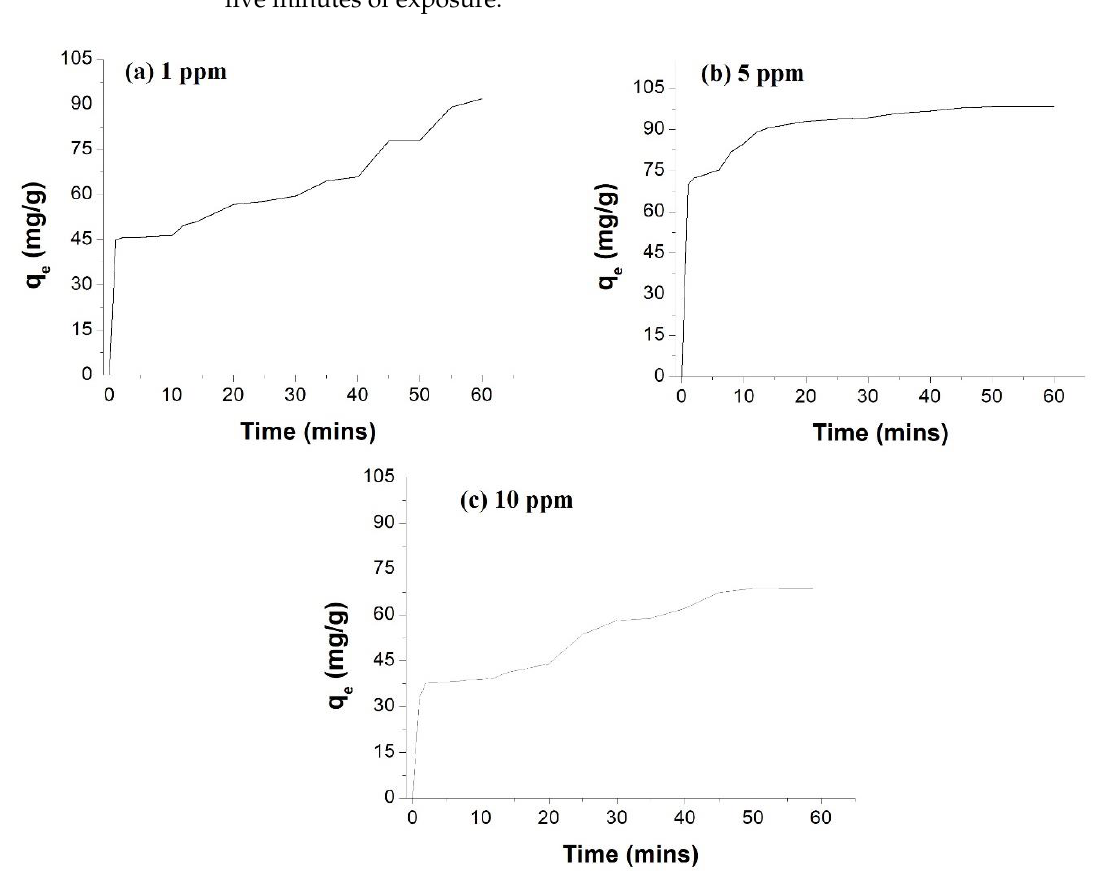
Figure 10. % Adsorption of PQ herbicide from water by free AgNPs at different initial AgNPs concentrations. Table 4. % Adsorption of Paraquat (PQ) by free AgNPs and AgNPs incorporated into the cellulose acetate membrane with different initial insecticide concentrations.